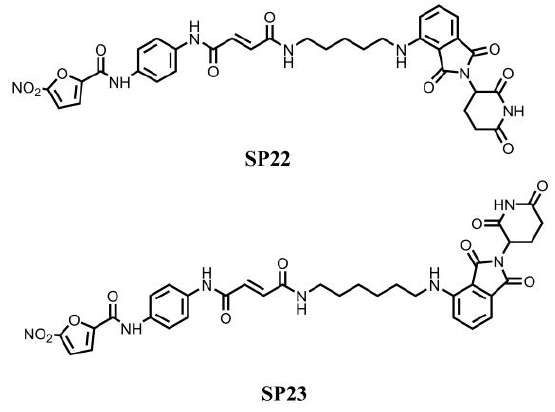
Figure 7. STING protein